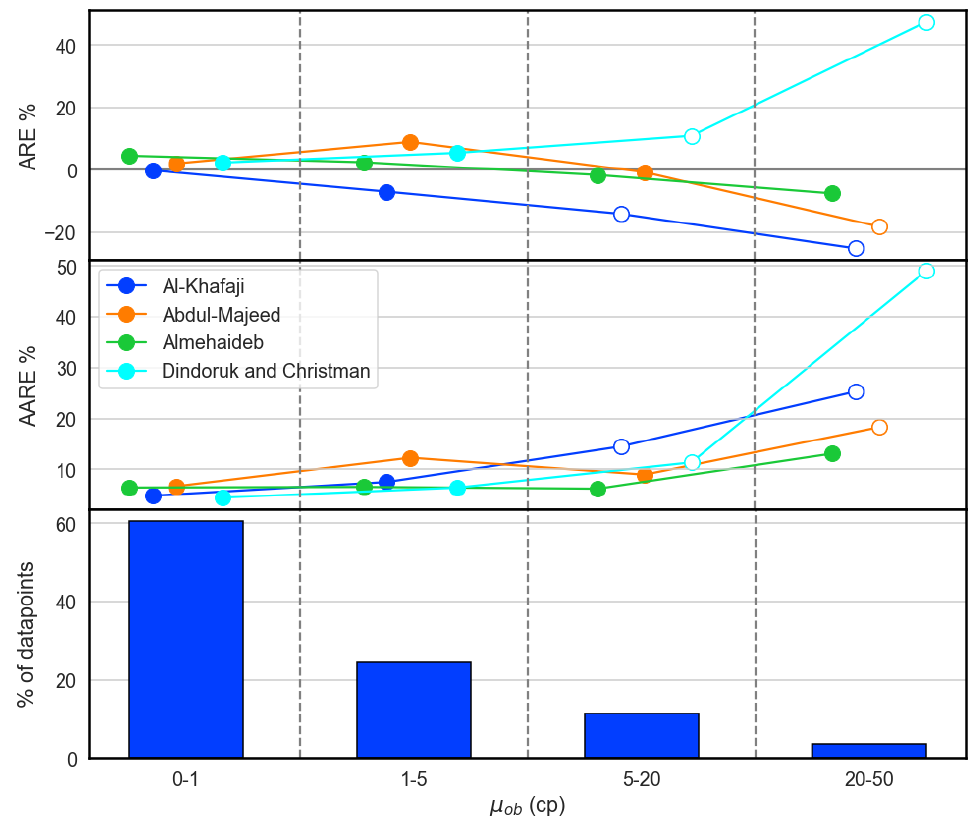
Figure 7. Evaluation of correlations in cluster B 2 (hollow points correspond to results obtained outside the development range of the